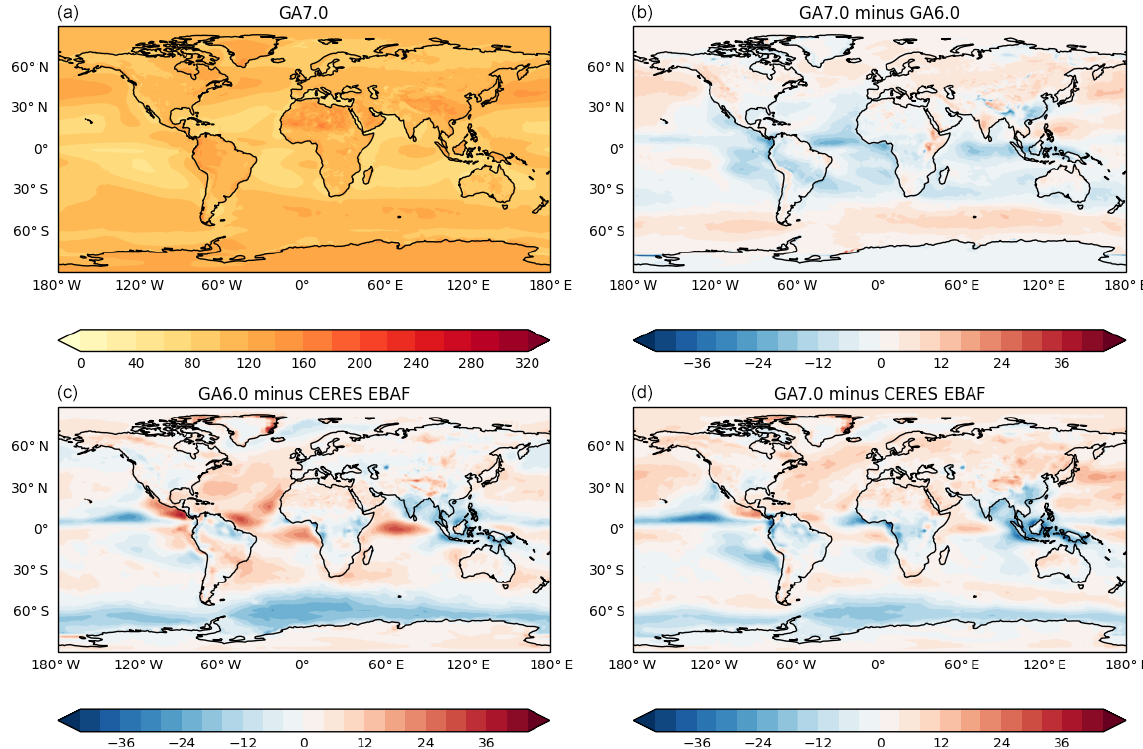
Figure 15. Annual mean top-of-atmosphere reflected SW radiation (Wm − 2 ) in the 27-year N216 atmosphere/land-only climate simulations presented in Fig. 12 compared to Clouds and the Earth’s Radiant Energy System (CERES) Energy Balanced and Filled (EBAF) dataset (Loeb et al., 2009). The layout is the same as in Fig.